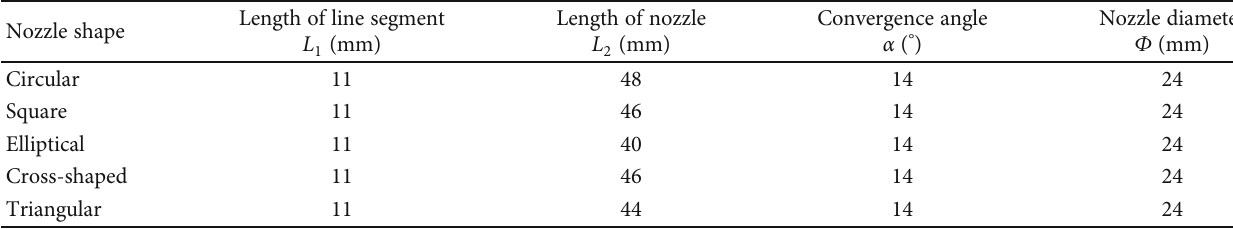
Figure 2: Internal structure and shapes of fi ve di ff erent nozzles. Table 1: Detailed parameters of